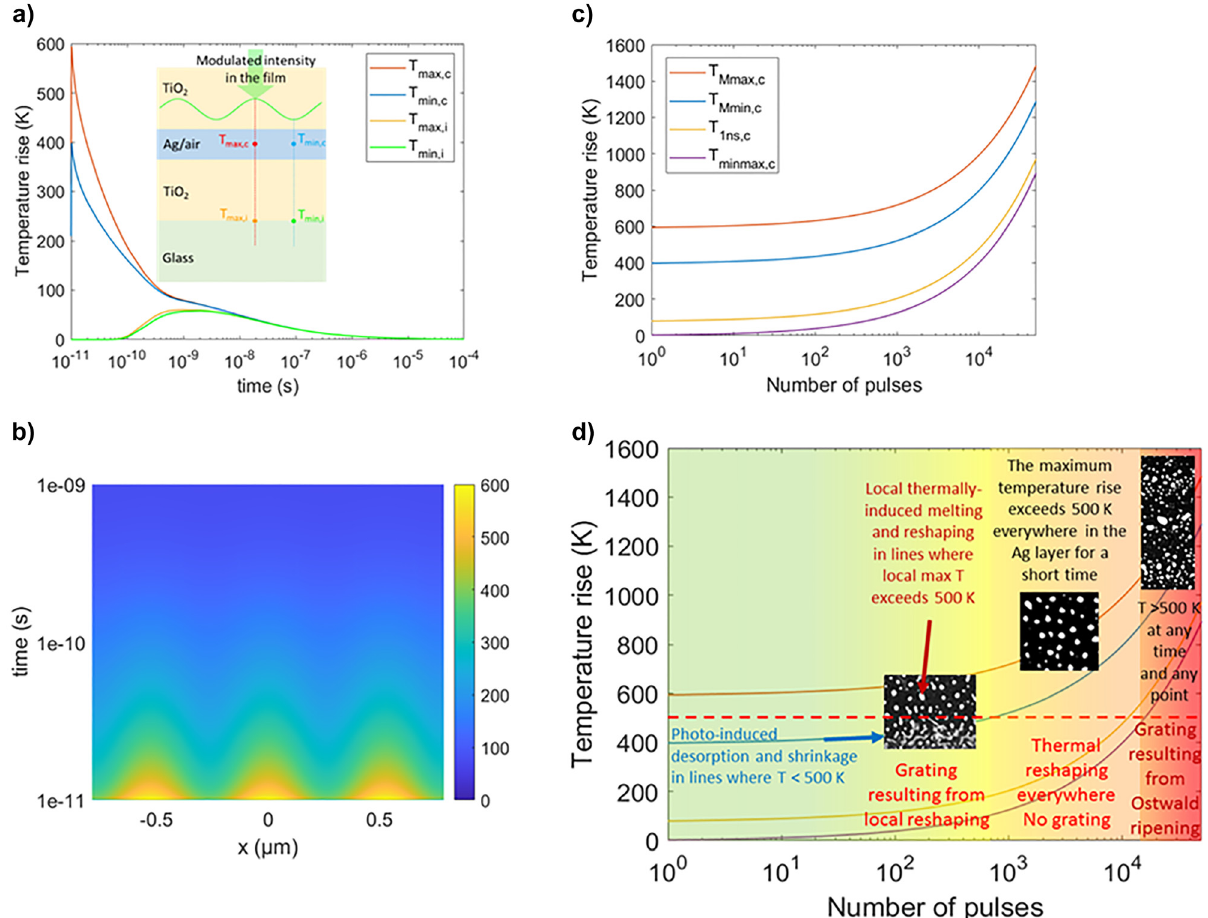
Figure 3: Simulation of the temperature rise at different positions and times in the multilayer system. (a) Time variations of the temperature increase simulated after the first fs laser pulse in the middle of the Ag/air layer where the modulated intensityismaximum( T max,c )orminimum( T min,c )andattheTiO 2 /glassinterface,wheretheintensityismaximum,( T max,i )orminimum,( T min,i ).The sketchinthe insetshows thelocationof the four pointsin the multilayersystem. (b) 2D color map of the temperature in the middle of the Ag/air layer as a function of time and space along the direction of modulation of intensity. (c) Pulse-to-pulse evolution of the maximum values of T max,c and T min,c (curves T Mmax,c and T Mmin,c ),thetemperatureriseinthemiddleofthe fi lmafter1nswhen T max,c alreadyequalsto T min,c (curveT 1ns,c ),and theminimumvalueof T max,c = T min,c justbeforethenextpulse(curve T minmax,c